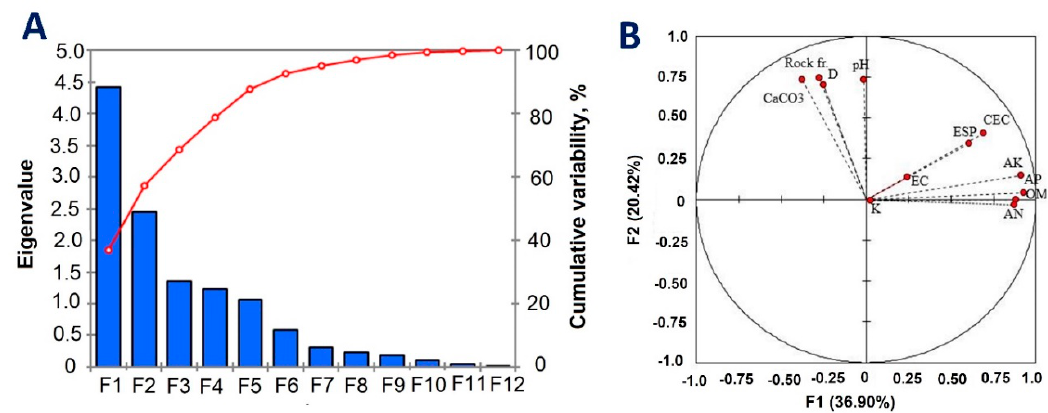
Figure5. Thescreeplotofeigenvalue( A )andprincipalcomponentanalysisbi-plot( B Figure 5. The scree plot of eigenvalue ( A ) and principal component analysis bi-plot ( B ) for soil properties.